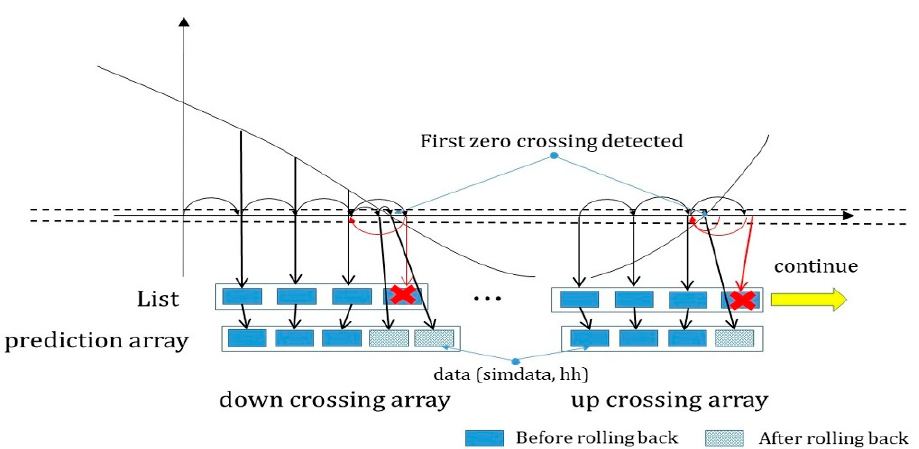
Figure 10. Zero crossing prediction with up and down crossing array.